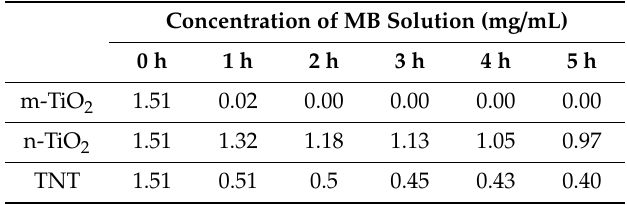
Figure 10. ( a ) Normalized concentration of methylene blue (MB) solution with pure photocatalysts and ( b ) the color change of the MB solution. Table 5. The decomposition of MB solution with pure photocatalysts.